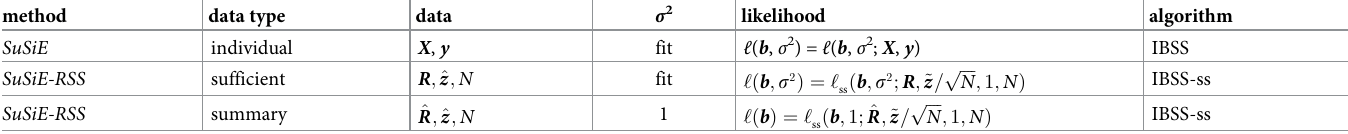
Table 1. Summary of SuSiE and SuSiE-RSS , the different data they accept, and the corresponding likelihoods. In the “likelihood” column, ~ z ≔ D 1 = 2 adjusted z -scores; see (17). In this summary, we assume X , y are standardized, which is common practice in genetic association studies. Note that when SuSiE-RSS is applied to sufficient statistics and σ 2 is estimated (second row), the likelihood is identical to the likelihood for SuSiE applied the individual-level data (first row). See https:// stephenslab.github.io/susieR/articles/susie_rss.html for an illustration of how these methods are invoked in the R package susieR